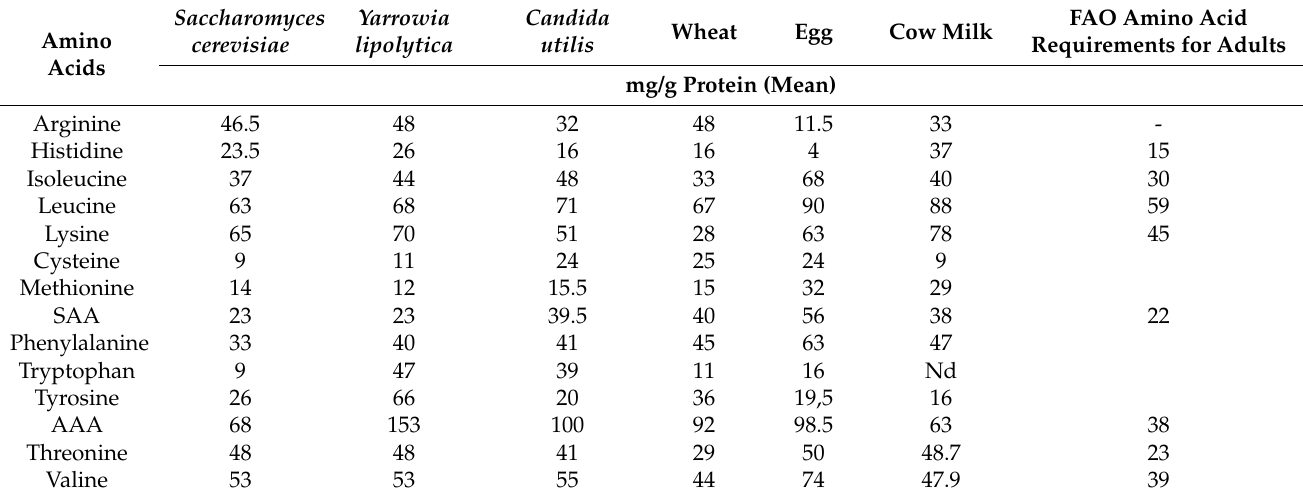
Table 3. Average contents of essential amino acids in protein compared to several protein sources (milligrams of amino acids per 1 g of